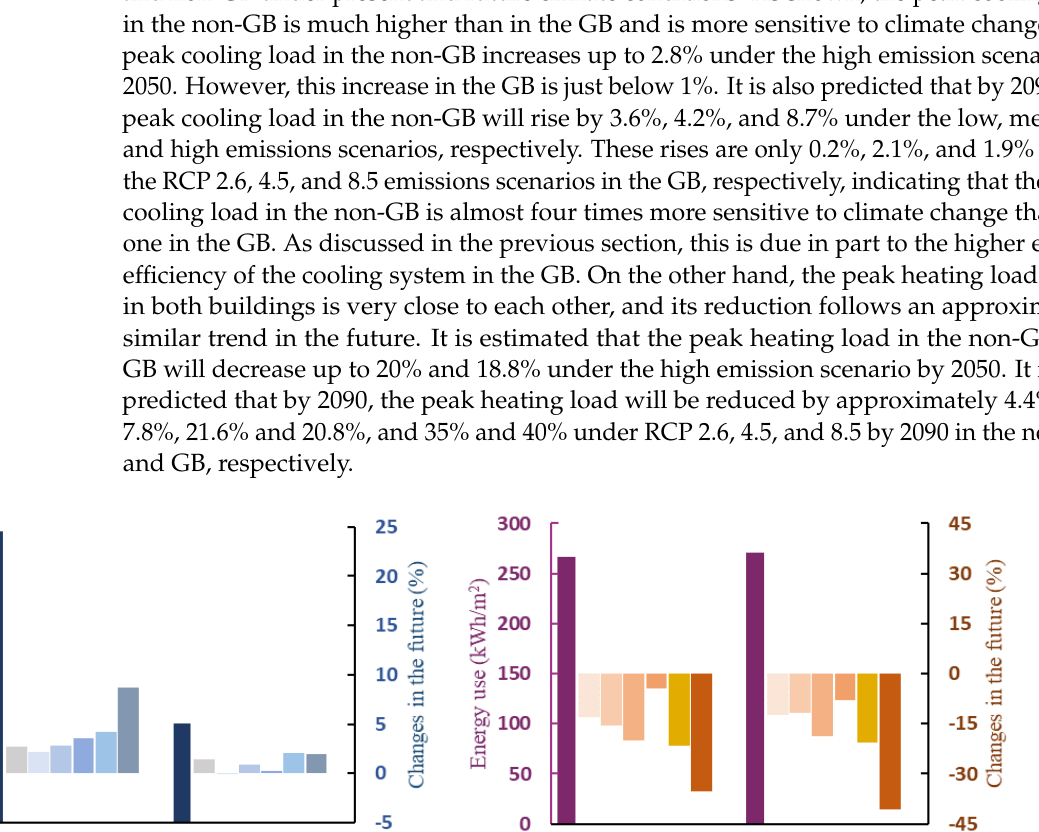
stalled on the roof. The system has 374 photovoltaic modules overall, with a total area of 625 m 2 . The modules are divided into three different arrays with a 3° tilt. The first array is oriented towards a 2° azimuth, the second array towards a 37° azimuth, and the third array towards a 65° azimuth. The whole system has a nominal power of 99.1 kWp with a 100 kWac inverter. Figure 8 represents the normalized production and performance ratio for the present situation. ( a ) ( b ) Figure 8. PV production: ( a ) normalized production per kWp installed; ( b ) performance ratio. Table 2 represents the predicted PV production for the three pathways introduced in this study, for the GB. The minimal solar production is registered, as expected, with the present climate.